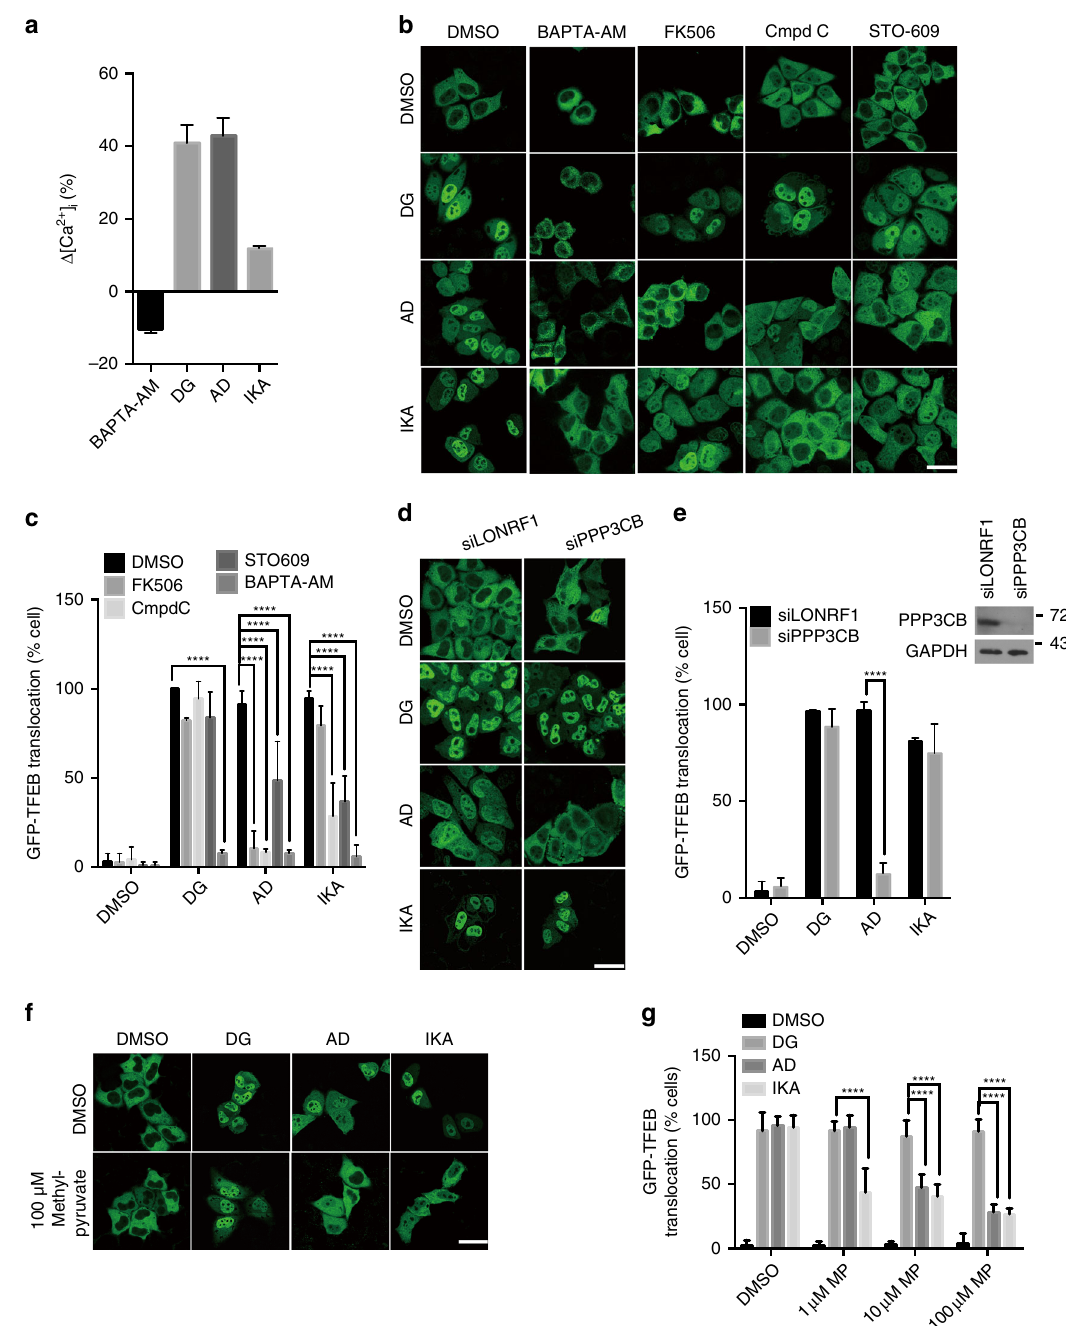
Fig. 4 Engagement of distinct Ca 2+ pathways by small-molecule agonists of TFEB. a Intracellular Ca 2+ concentration was measured in wild-type HeLa cells treated with 5 μ M BAPTA-AM, 370 nM DG, 3.3 μ M AD, and IKA using Fura-2-AM, and the concentration difference between compound-treated and DMSO-treated cells was normalized to the Ca 2+ concentration in DMSO-treated cells ( n = 3 independent experiments). b Confocal images of GFP-TFEB HeLa cells treated with 5 μ M BAPTA-AM, 5 μ M FK506, 10 μ M compound C (Cmpd C) and 25 μ M STO-609 together with 370 nM DG, 3.3 μ M AD, and IKA for 4 h. Scale bar, 20 μ m. c The graph represents the percentage of cells with GFP-TFEB translocation in b (mean ± s.d. for n = 3 independent experiments, **** p < 0.0001 by two-way ANOVA). d Representative images of GFP-TFEB HeLa cells treated with DG, AD, and IKA together with control siRNA (siLONRF1) treatment, siRNA-mediated inhibition of PPP3CB (siPPP3CB) or in combination with 5 μ M calcineurin inhibitor FK506 for 4 h. Scale bar, 20 μ m. e The graph represents the percentage of cells with GFP-TFEB translocation in d (mean ± s.d. for n = 3 independent experiments, **** p < 0.0001 by two-way ANOVA). Inset shows the immunoblot of HeLa cells treated with siLONRF1 or siPPP3CB. f Cell-permeable pyruvate can reverse the TFEB nuclear translocation induced by AD and IKA, but not DG. Scale bar, 20 μ m. g The graph represents the percentage of cells with GFP-TFEB translocation in f (mean ± s.d. for n = 3 independent experiments, **** p < 0.0001 by two-way